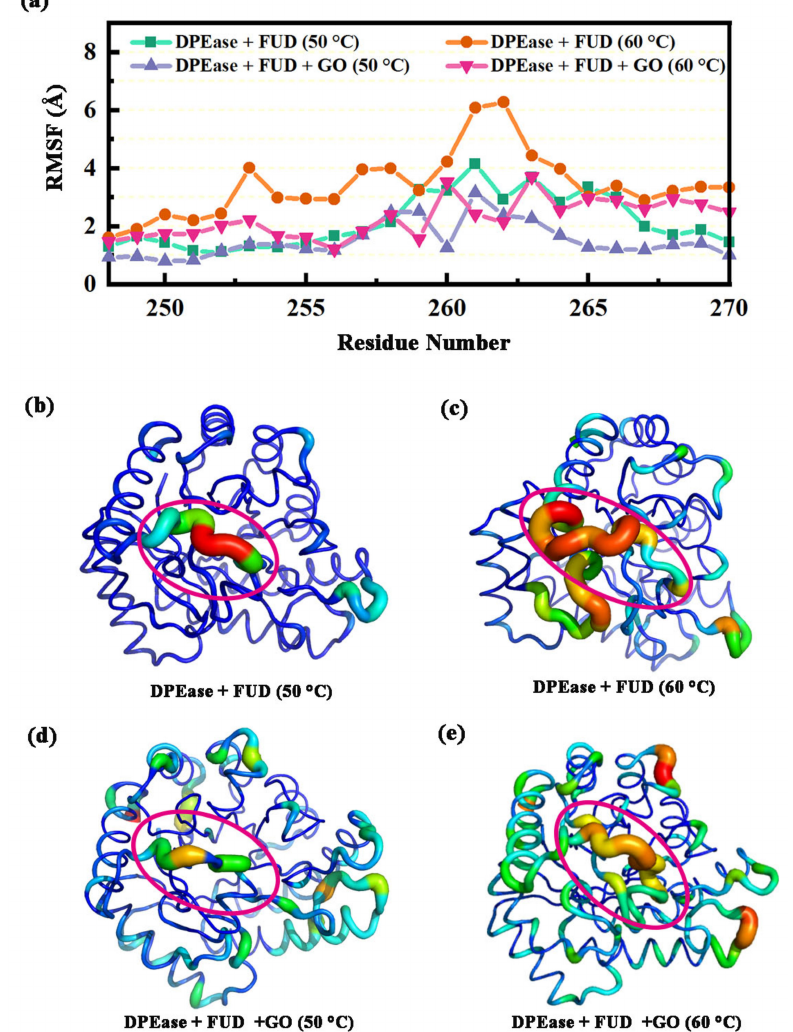
Figure 6. ( a ) The RMSF values of residues 248–268 for four systems; visualizations of the backbone flexibility for ( b ) DPEase + FUD (50 ◦ C); ( c ) DPEase + FUD (60 ◦ C); ( d ) DPEase + FUD + GO (50 ◦ C); ( e ) DPEase + FUD + GO (60 ◦